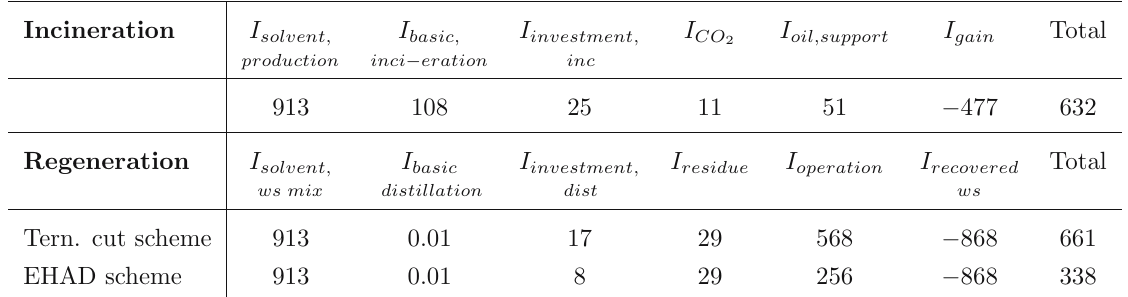
Table 4 LCA results of the total recovery and total incineration of the waste solvents expressed with Eco-indicator